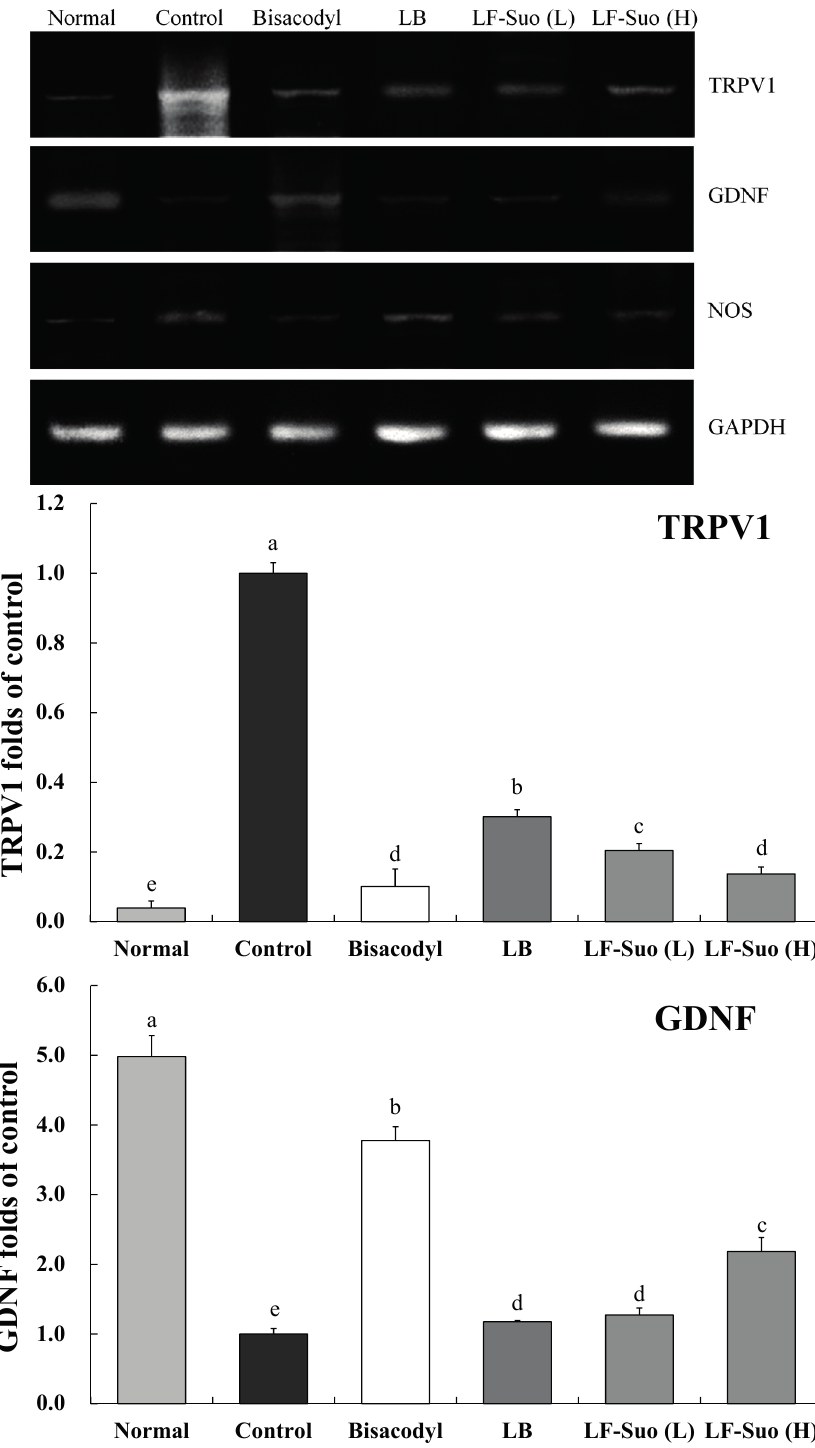
Figure 6. Effects of Lactobacillus fermentum Suo on the mRNA expression of TRPV1, GDNF and NOS in small intestine. n = 10 ICR mice in each group, bisacodyl: 100 mg/kg b.w.; LB: Lactobacillus bulgaricus (1.0 × 10 9 CFU/kg b.w.); LF-Suo (L): Lactobacillus fermentum Suo (0.1 × 10 9 CFU/kg b.w.); LF- Suo (H): Lactobacillus fermentum Suo (1.0 × 10 9 CFU/kg b.w.); a–f Mean values with different letters over the bars are significantly different ( p < 0.05) according to Duncan’s multiple range